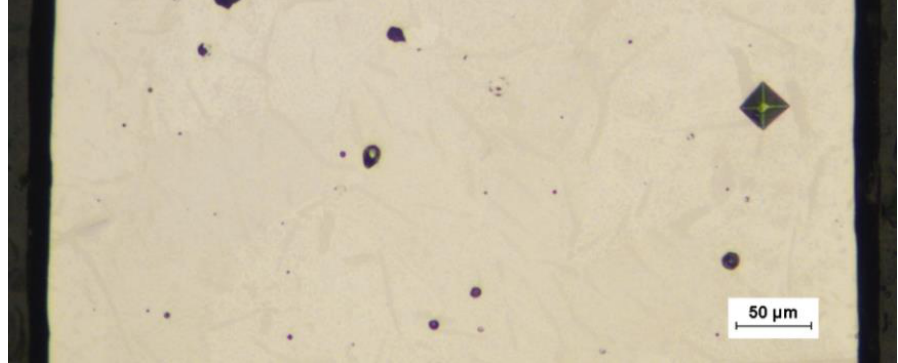
Figure 9. A typical micro Vickers indentation near the surface of a sintered titanium strip.